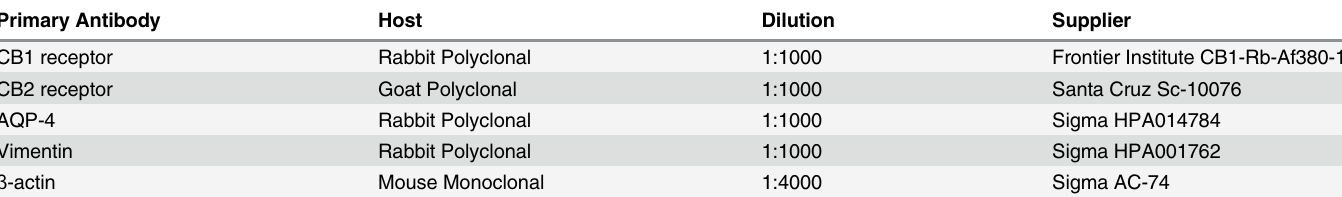
Table 3. Primary antibodies and dilutions used for Western Blot